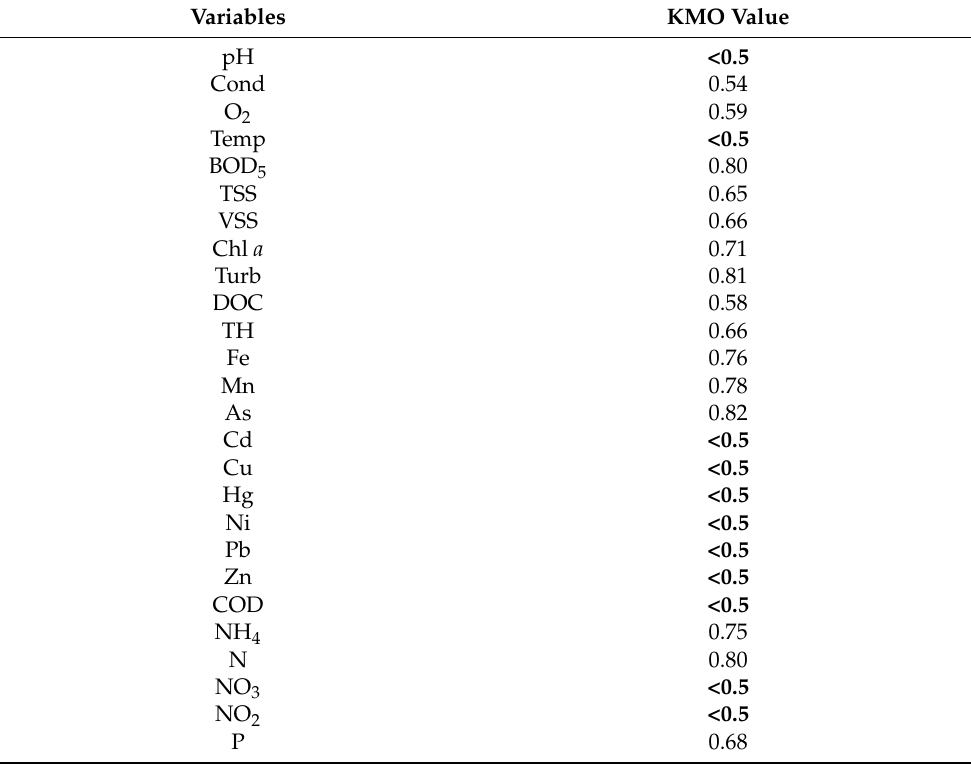
Table A1. Individual KMOs for each variable. O 2 is oxygen concentration, Cond is conductivity, Temp is temperature, TSS is total suspended solids measured In Situ, Chl a is the chlorophyll a measured In Situ, BOD 5 is the five-days biochemical oxygen demand, VSS is the volatile suspended solids, Turb is the turbidity, DOC is the Dissolved Organic Carbon, TH is the title hydrometric, Fe is iron, Mn is manganese, As is arsenic, Cd is cadmium, Cu is copper, Hg is mercury, Ni is nickel, Pb is lead, Zn is zinc, COD is chemical oxygen demand, NH 4 is ammonium, N is Kjedahl nitrogen, NO 3 is nitrate, NO 2 is nitrite and P is phosphorus. In bold are the variables not included in the PCA matrix, as their value is below